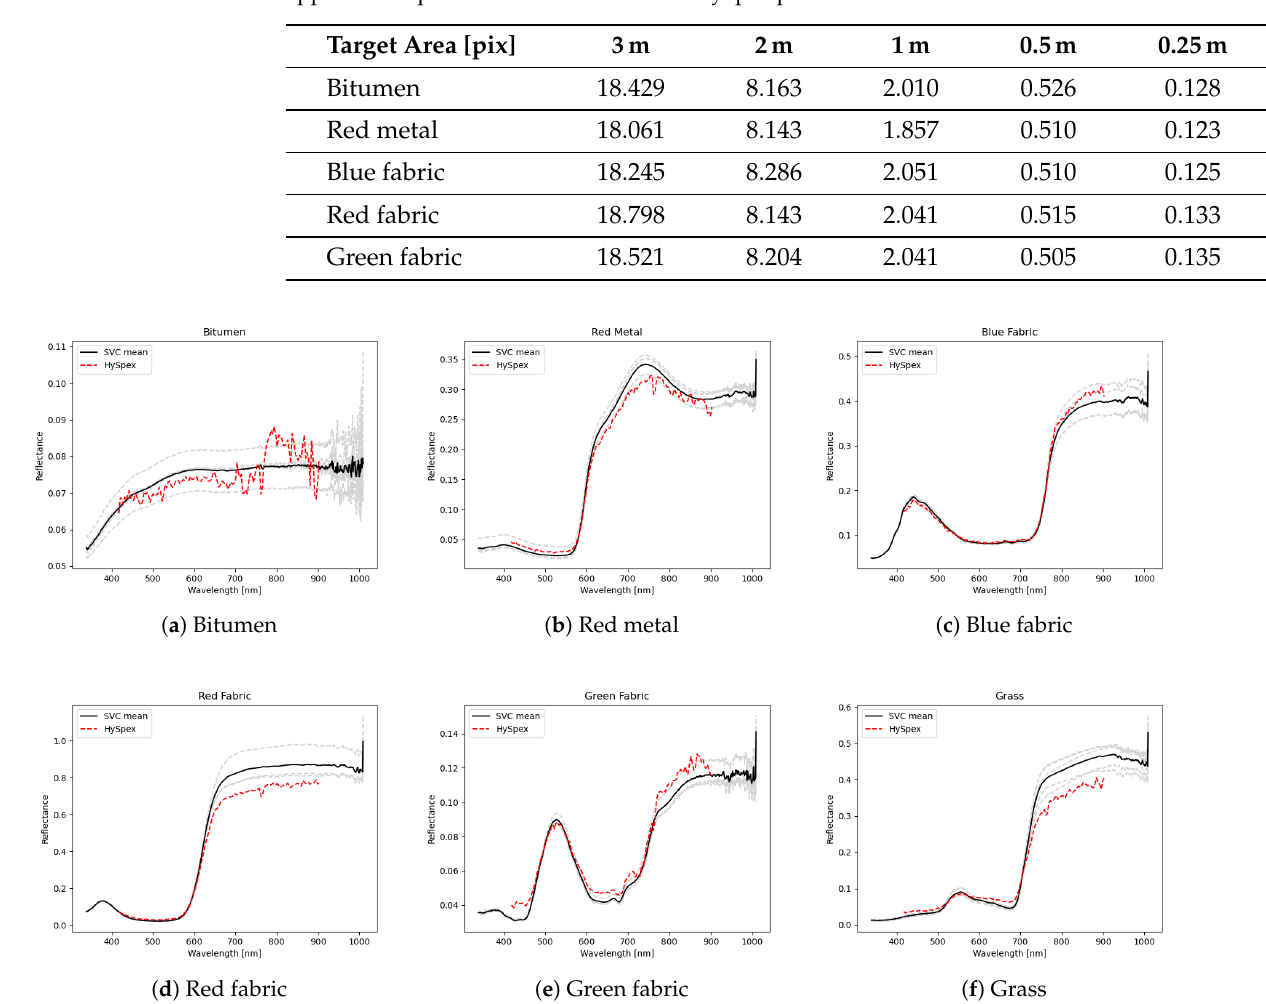
Figure A1. HySpex spectra for each material in Figure 5 compared to in-situ measurements carried out with an SVC